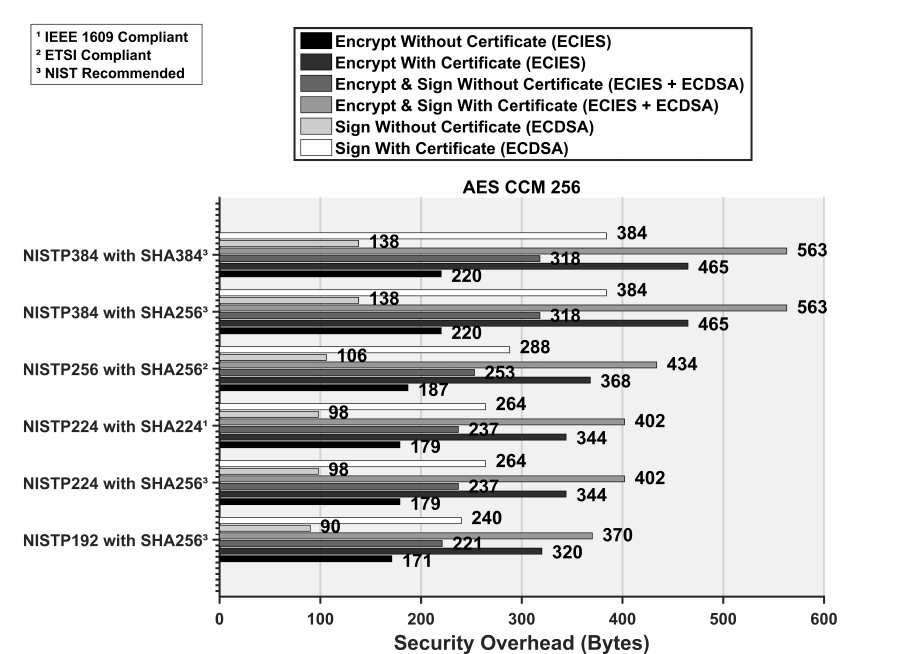
Figure 11. Security overhead required for different security procedures in conformance with the IEEE WAVE and the ETSI standard at AES CCM 256.